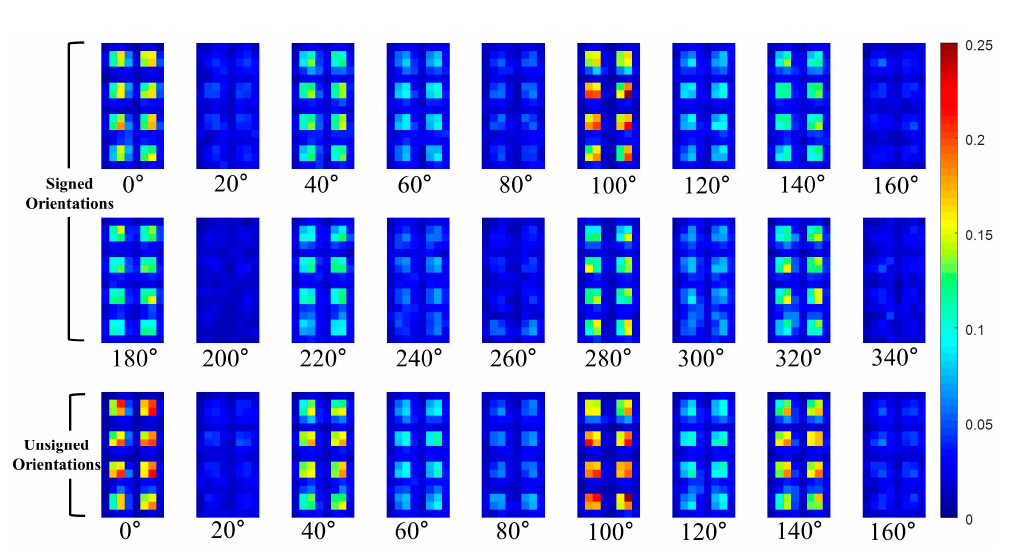
Figure 9. Average of P parts of T π HOG for pedestrians.